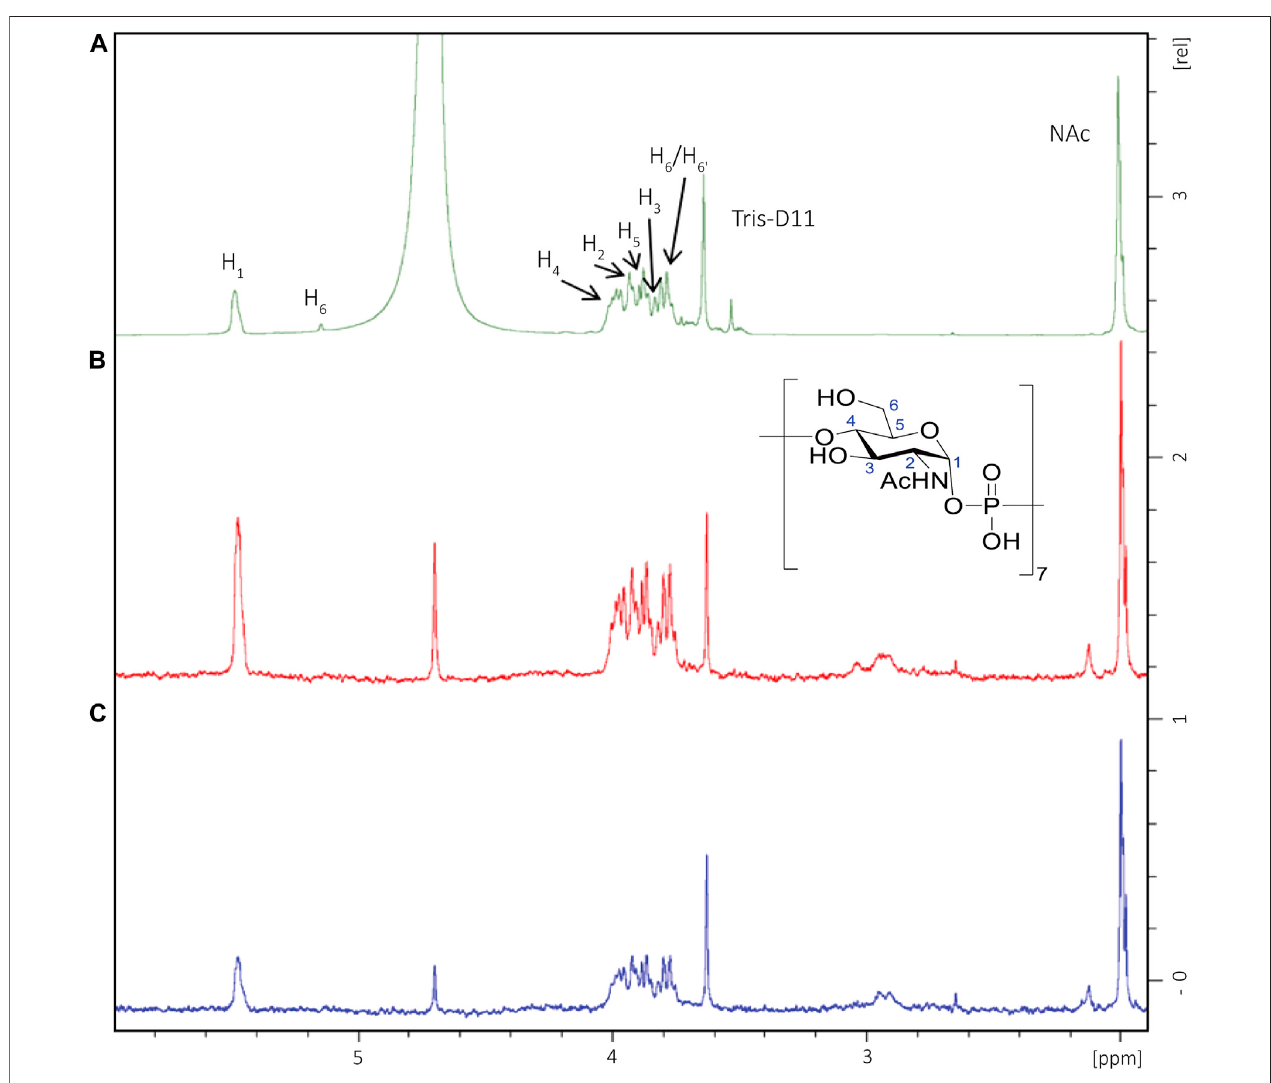
FIGURE4| STD-NMR(D 2 O,600 MHz)ofaDP7fragmentincomplexwithMenX0.1mAb. (A) 1 HNMRoftheoligosaccharideinthepresenceofMenX0.1mAb(50: 1 M ratio). (B) STD NMR spectrum obtained for the complex upon on-resonance irradiation at 7 ppm; (C) STD-NMR spectrum obtained for the complex upon on- resonance irradiation at 8 ppm. All sugar ring protons display transfer of saturation, with higher relative intensities for positions H-1 and H-4.